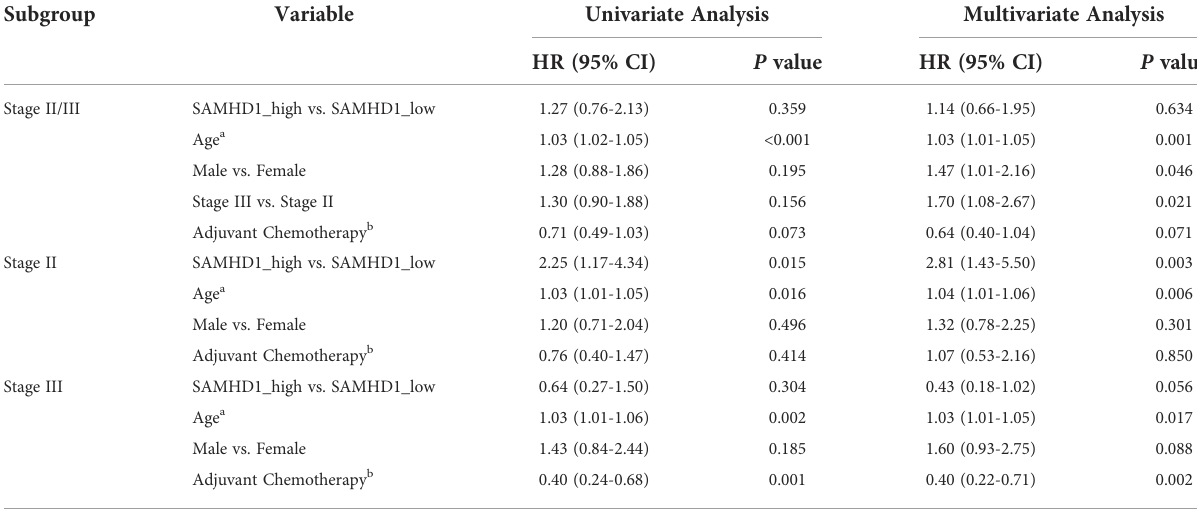
TABLE 2 Univariate and multivariable Cox analyses for overall survival among patients in the validation data set.